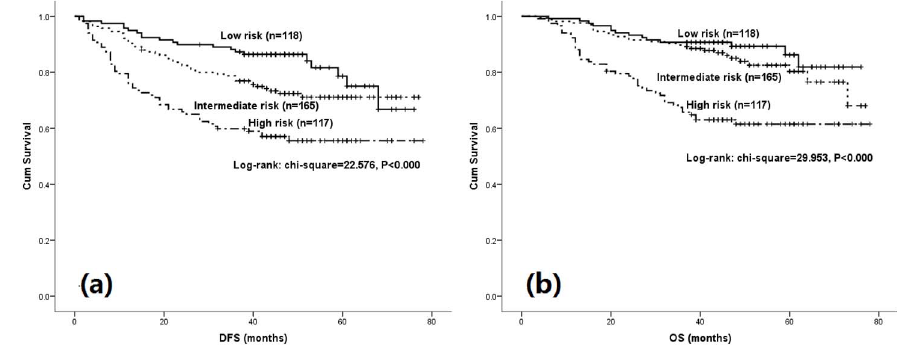
Figure 2. Kaplan-Meier estimates according to low, intermediate and high risk groups on DFS (a) and OS (b).